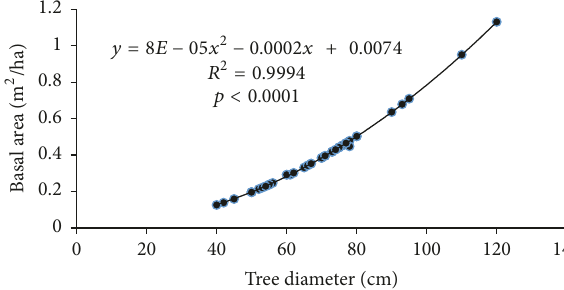
Figure 3: Relationship between tree diameter and basal area in Nkrabea forest reserve. Notice that the basal area increased with the increase in tree diameter.